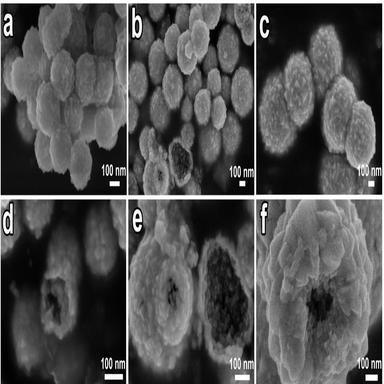
SEM images of (a, d) Cu2O-HNs1, (b, e) Cu2O-HNs2, and (c, f) Cu2O-HNs3, respectively.